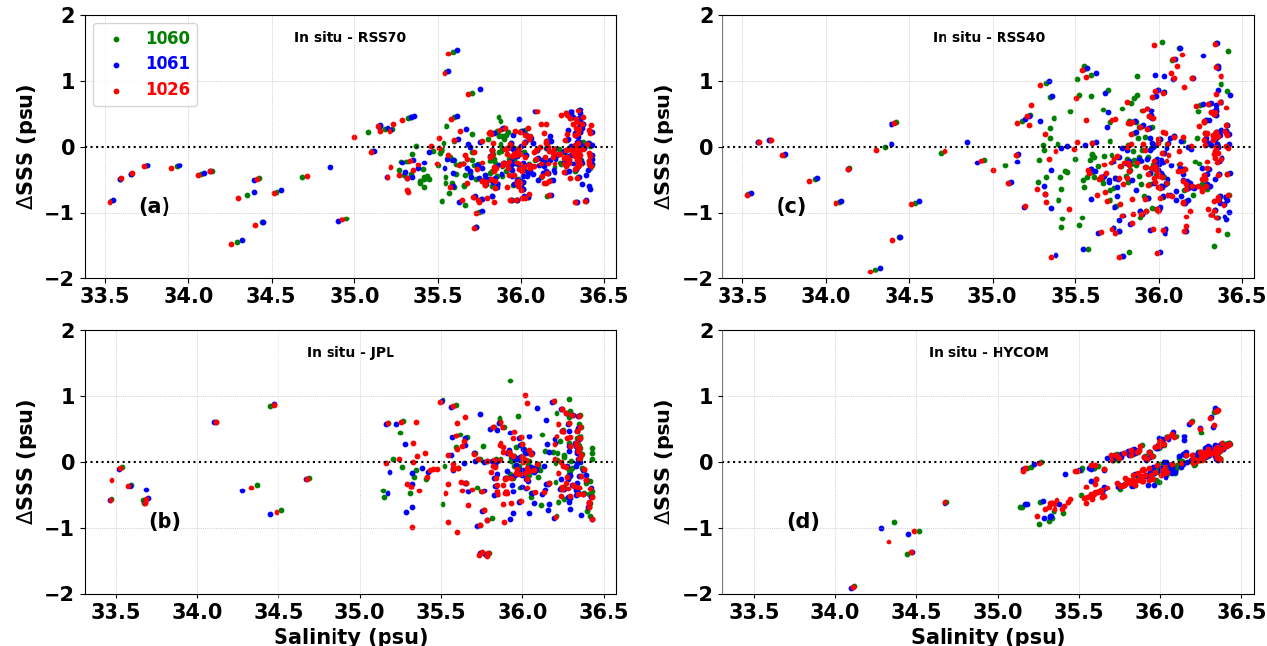
Figure 5. Sea surface salinity difference versus sea surface salinity between ( a ) RSS70, ( b ) JPL and ( c ) RSS40 (orbital L2 no repeat data) and ( d ) HYCOM and the saildrone instrument SBE37 as recorded by saildrones 1026, 1060 and 1061.